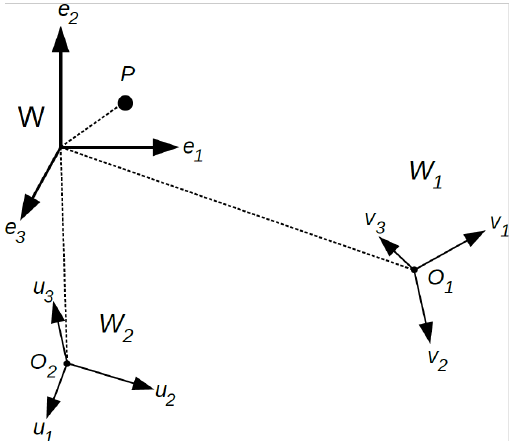
Fig. 21: Global ( W ) and camera reference systems for two consecutive